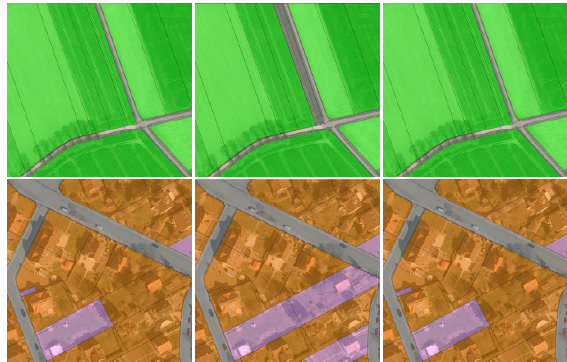
Figure 2: Ground truth (left column), classification results exclusively based on association potentials (centre column), results of the CRF approach (right column). Colours: res. (red), street (grey), agr. (green), forest (dark green), others (pink). The relevance of features results from a permutation importance measure (Breiman, 2001), which can be obtained from the RF classifier. An analysis of the overall importance values per feature shows a large influence of the contextual features on the classification accuracy, as the two most relevant features belong to this group, namely the ratio of the areas covered by the land cover classes building and vegetation to the total area. Figure 3 shows the predicted overall accuracy achieved by progressively including features in the classification according to their importance value, starting with the most relevant one. The predicted overall accuracy converges to a value of approximately 85%, which is already achieved with the use of the 20 most relevant features.